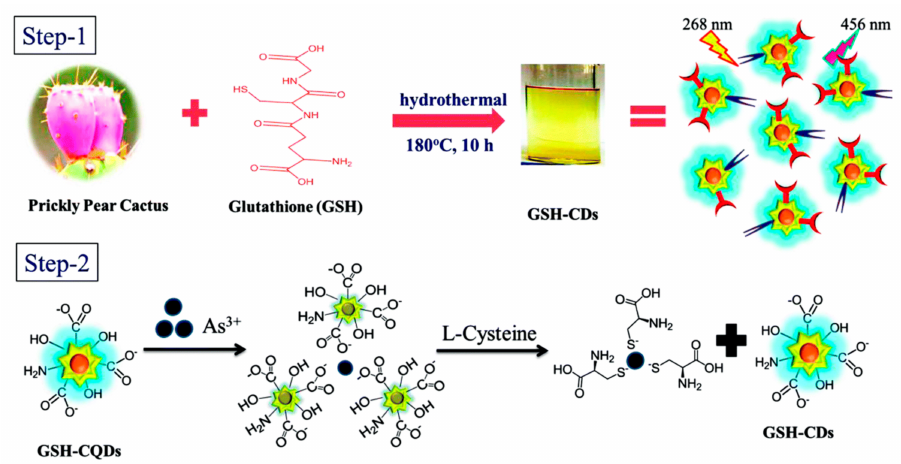
Figure 5. Illustration of synthetic route for obtaining GSH-CQDs and working principle toward the sensitive detection of As 3+ metal ions. Reprinted from Ref.